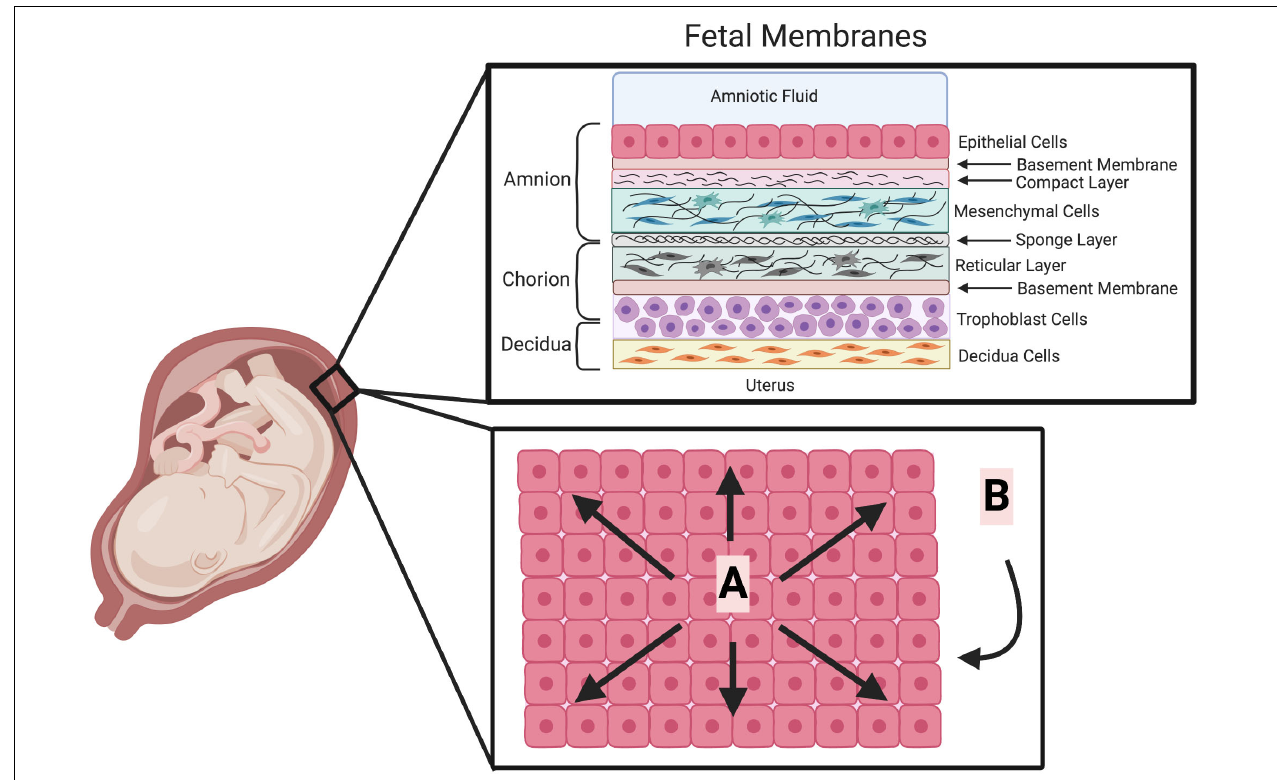
FIGURE 1 | The cellular structure of the fetal membranes and their biophysical forces. The human fetal membranes consist of a multi-layered structure which surround the fetus in utero. It is composed of the amnion, chorion and decidua (upper box). Biophysical forces are placed on these fetal membranes (lower box depicted looking down onto the apical surface of the amnion epithelium). (A) Linear physical forces due to multi-directional stretching of the fetal membranes adherent to the decidua. (B) Dynamic physical forces on the fetal membranes due to fetal movements, Braxton Hicks contractions and eventually labor. (This Figure was created using